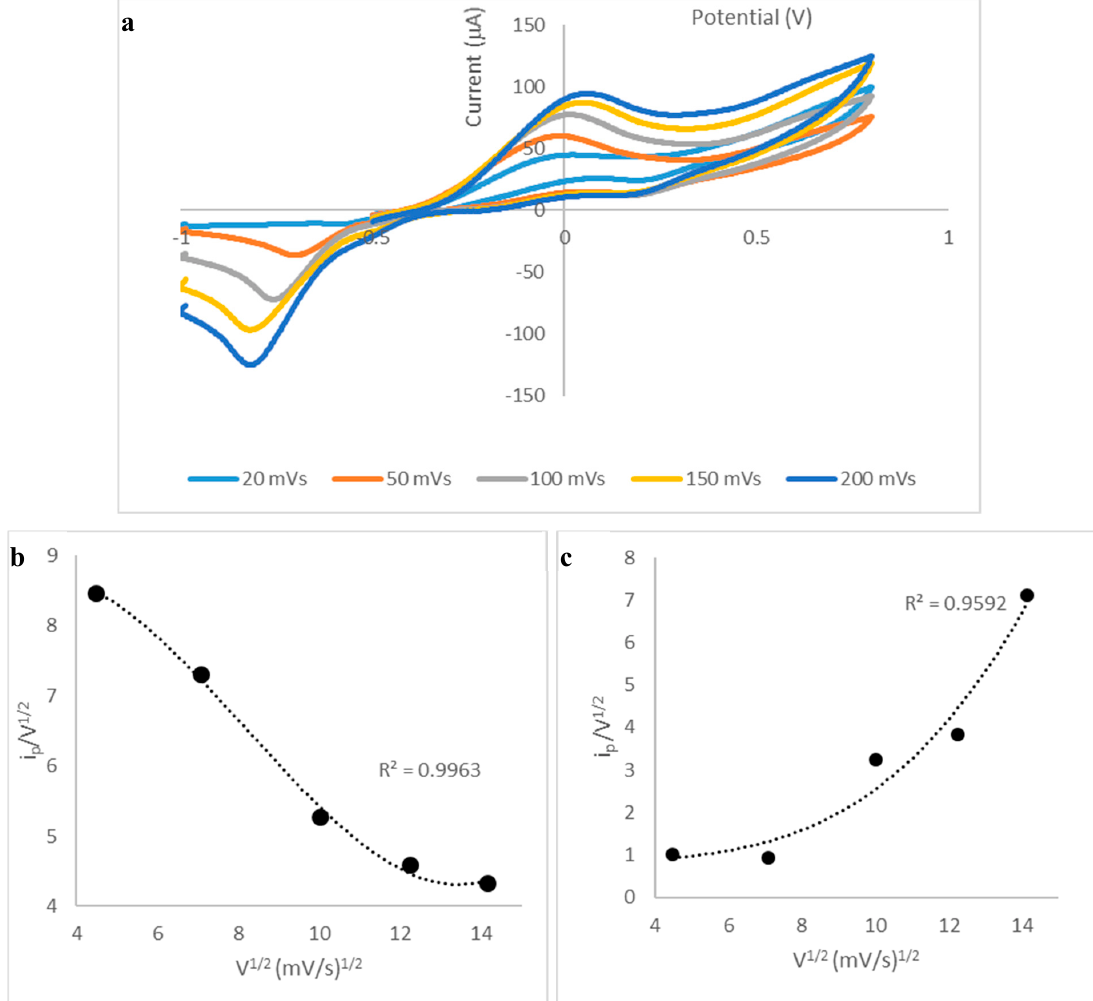
Figure 4. ( a ) Cyclic voltammograms obtained for 10 mM vitamin B1 in 0.1 M PBS at various scan rates